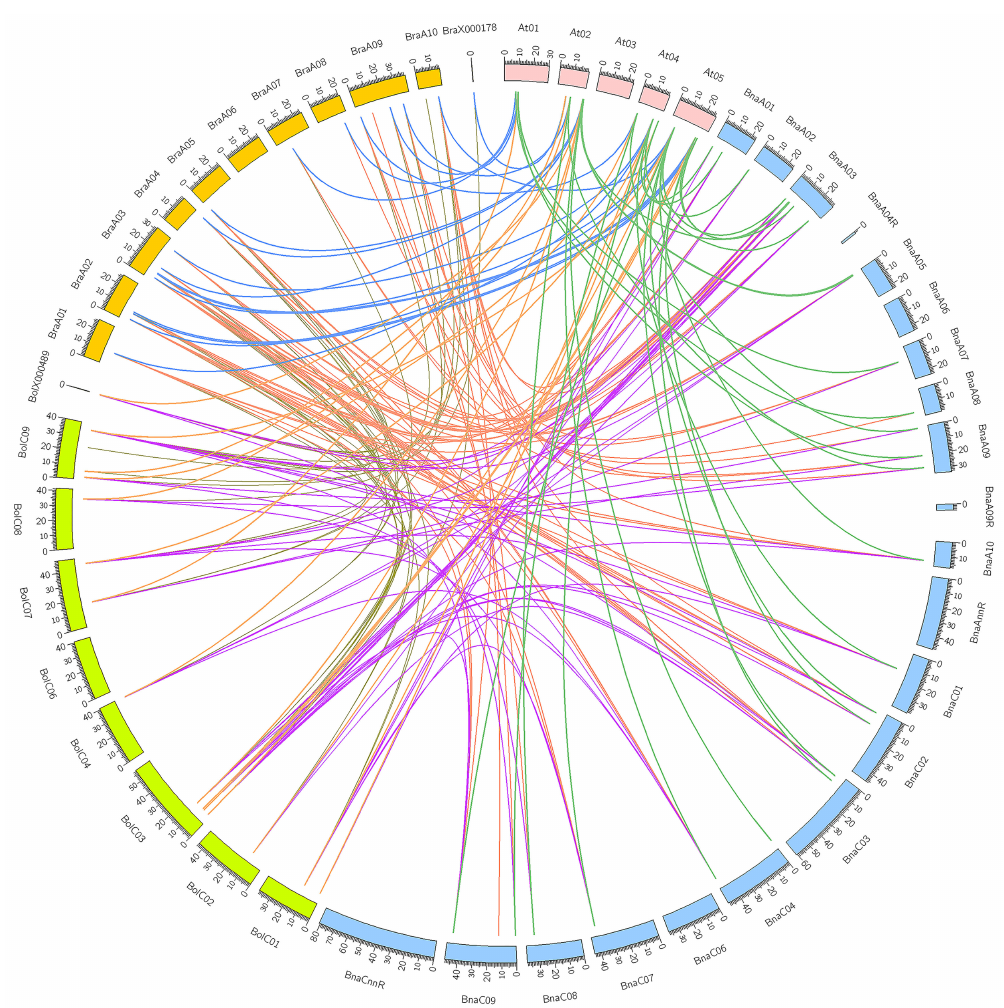
Figure 2. The synteny analysis of GH3 genes in the three species of Brassica and Arabidopsis thaliana